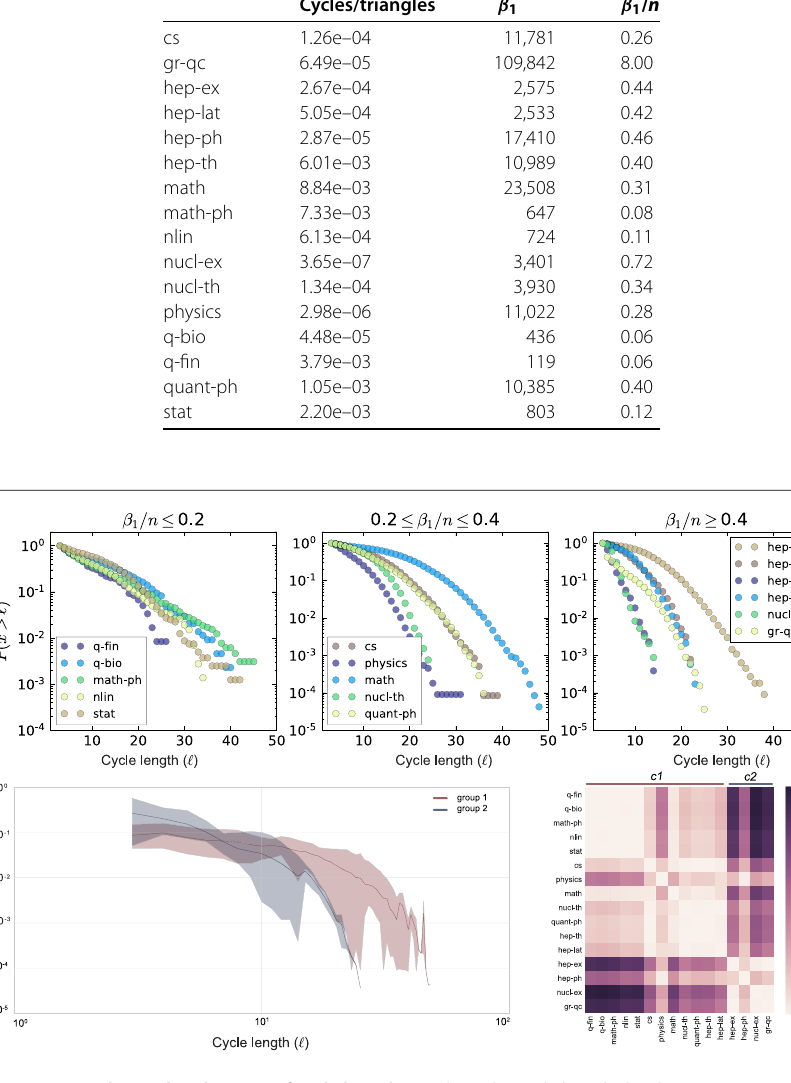
Figure 6 Cumulative distributions of cycle length. We show the cycle length distributions (top) and their Jensen-Shannon divergence (bottom right) for all categories, ordered by β 1 / n value. We find two main groups of categories, which we highlight with different colors (bottom left). We groups categories in the subplots by growing values of β 1 / n (top, from left to right) and note that as the cycle sparsity increases, the maximum cycle length